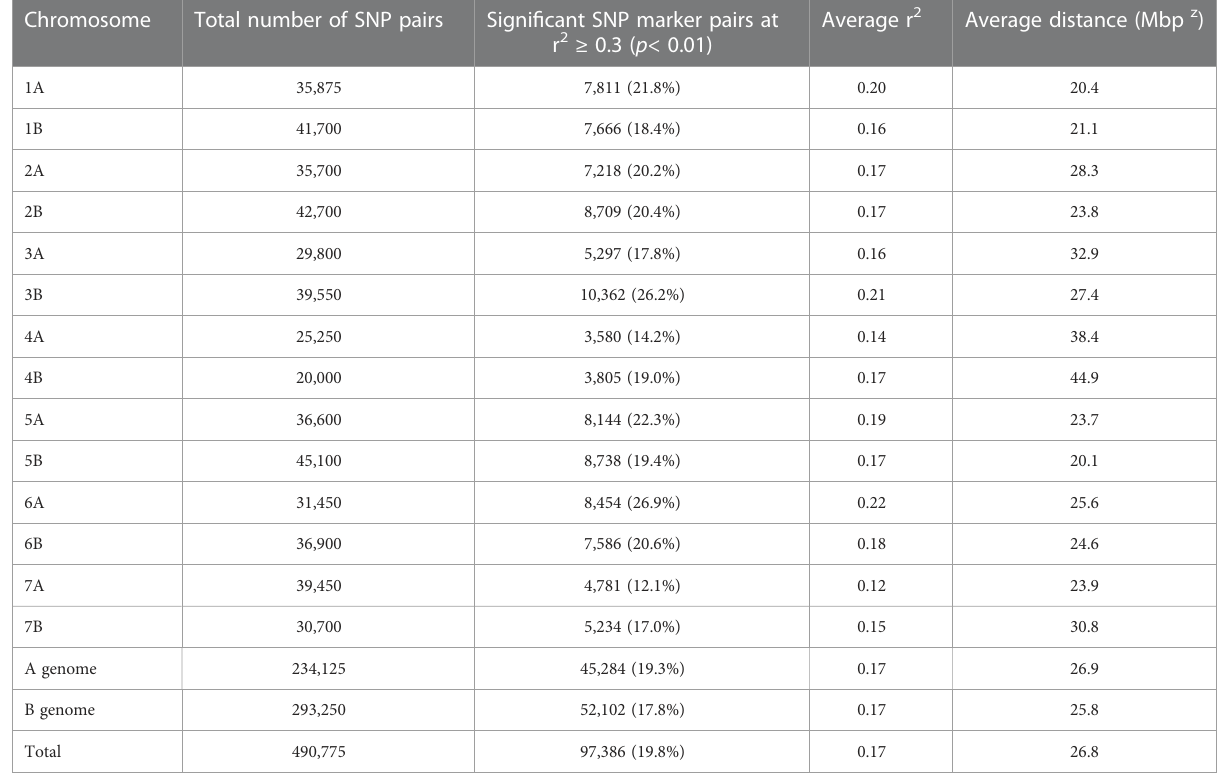
TABLE 3 A summary of linkage disequilibrium analysis for SNP marker pairs and the distribution of signi fi cant SNP pairs across each chromosome of each genome. Chromosome Total number of SNP pairs Signi fi cant SNP marker pairs